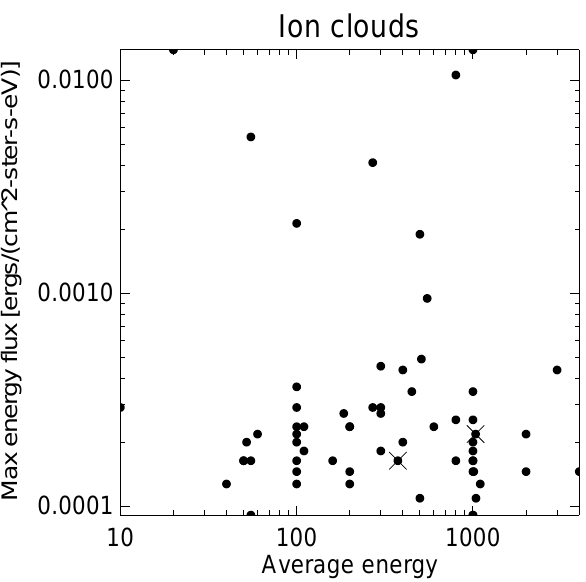
Fig. 3. Distribution of maximum energy flux and average energy of ion clouds. The chosen examples of Figs. 1 and 2 are marked by